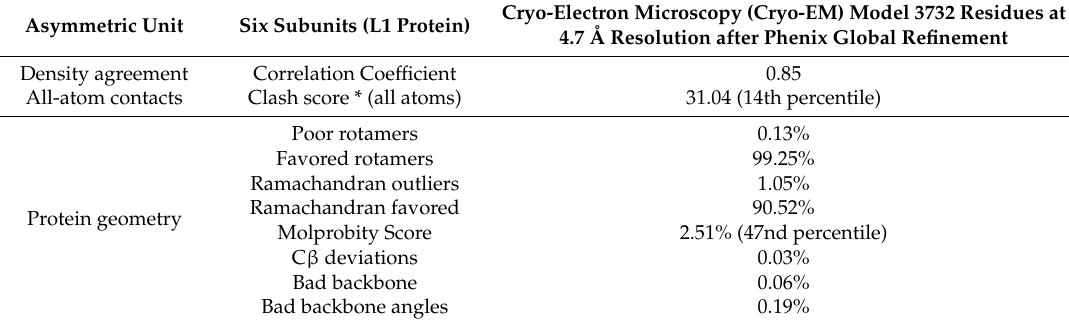
Table 2. Molprobity Statistics for HPV-V5.